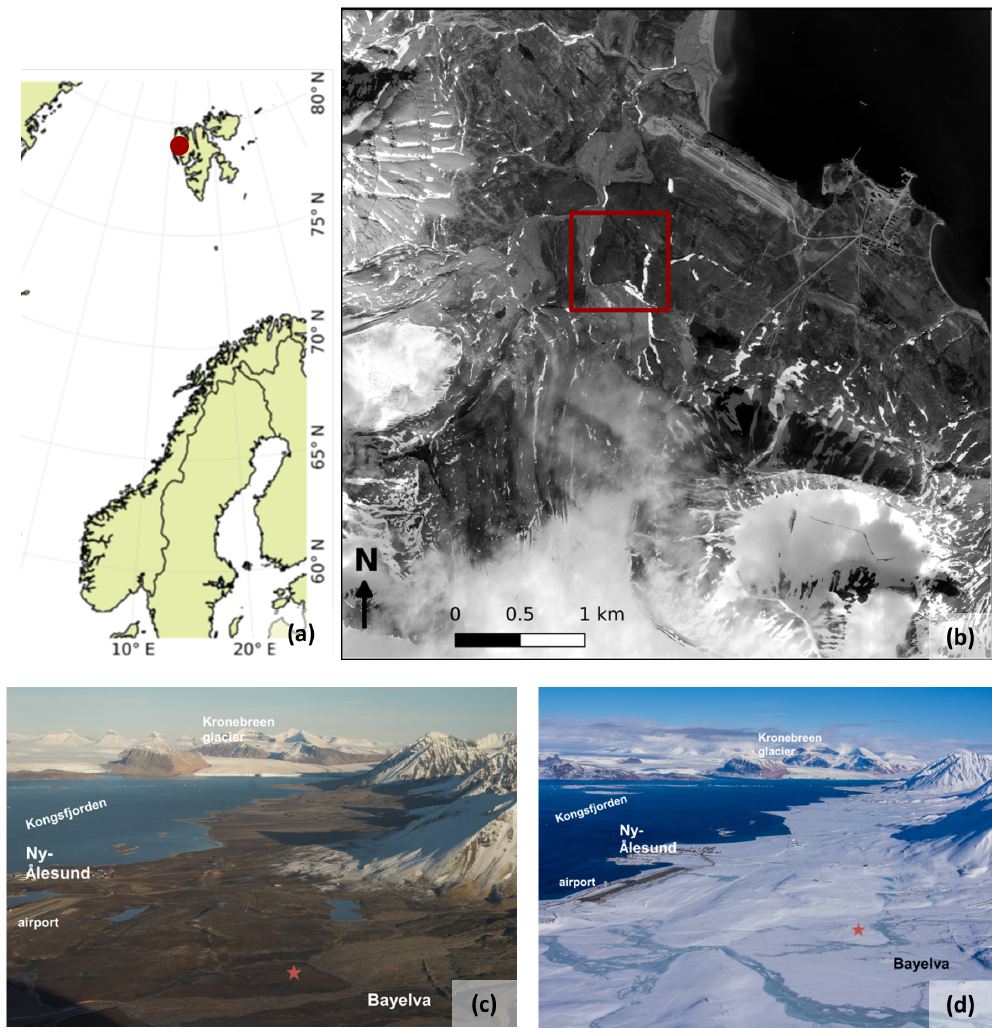
Figure 1. (a) Location of the Bayelva study site on Spitsbergen, western Svalbard, at 78.92094 ◦ N, 11.83334 ◦ E. (b) The site is located about 3km from Ny-Ålesund in the Bayelva River catchment area, between two mountains (Zeppelinfjellet and Scheteligfjellet), and in front of the Brøggerbreen glacier. Aerial image captured in August 2008 using the high-resolution HRSC-AX camera (Hauber et al., 2011a, b): data and metadata for the high resolution the HRSC-AX image covering the entire area shown in (b) are provided in Appendix B. (c) The area of the site under summer conditions (August 2008) and (d) under spring conditions (April